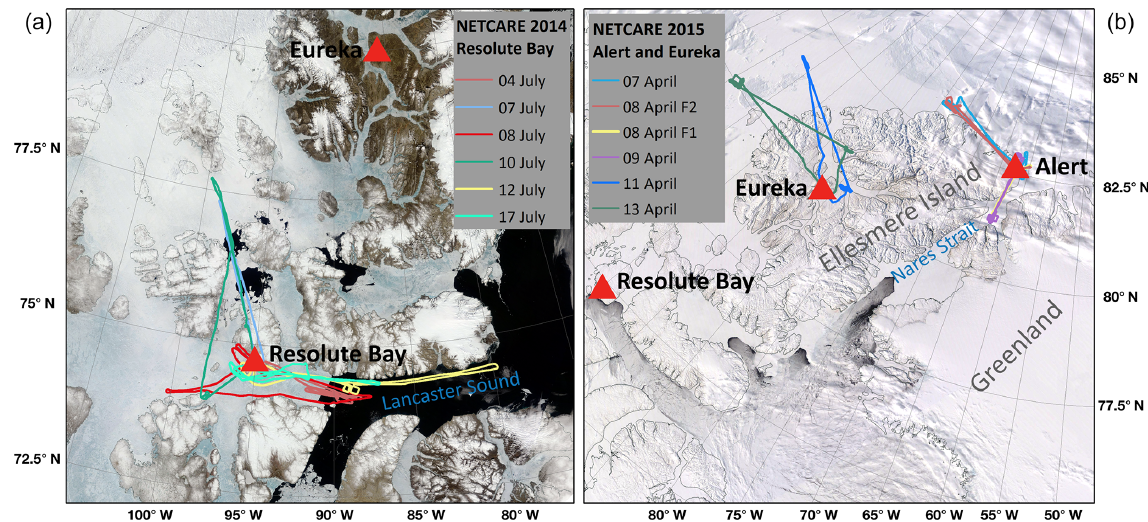
Figure 1. Maps of all flight tracks evaluated in this study. The summer measurement flights were operated out of Resolute Bay on the northern shore of Lancaster Sound, southern Canadian Arctic Archipelago (a) . The spring campaign operated from Alert and Eureka on Ellesmere Island (b) . MODIS satellite true-colour images were obtained from https://worldview.earthdata.nasa.gov (last access: 10 February 2019). Table 1. An overview of all measurement flights of the NETCARE summer campaign 2014 and the spring campaign 2015 that are evaluated in this study. The stations are the Arctic airfields the plane started from and returned to (see Fig. 1). Two flights took place on 8 April 2015, which are referred to with the shorthand notations F1 and F2.